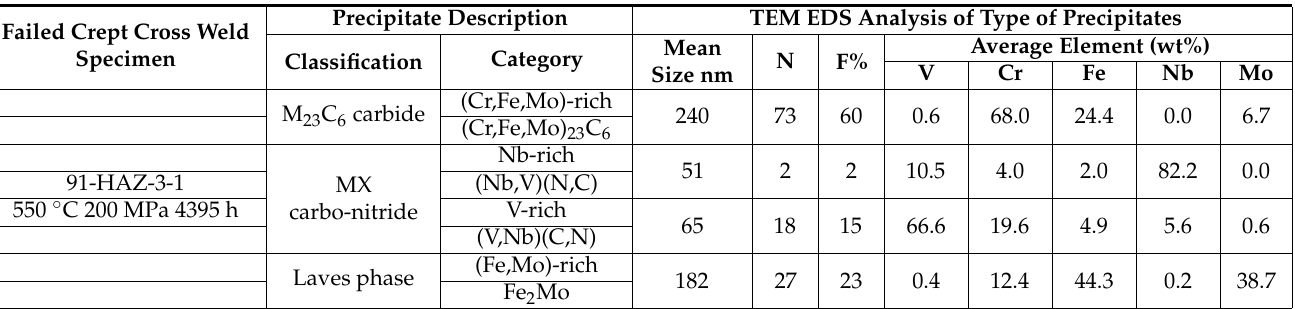
Table 13. Failed crept cross-weld specimen 91-HAZ-3-1 550 ◦ C 200 MPa 4395 h. Assessment of geometrical parameters and the mean chemical compositions of different types of precipitates by TEM-EDS